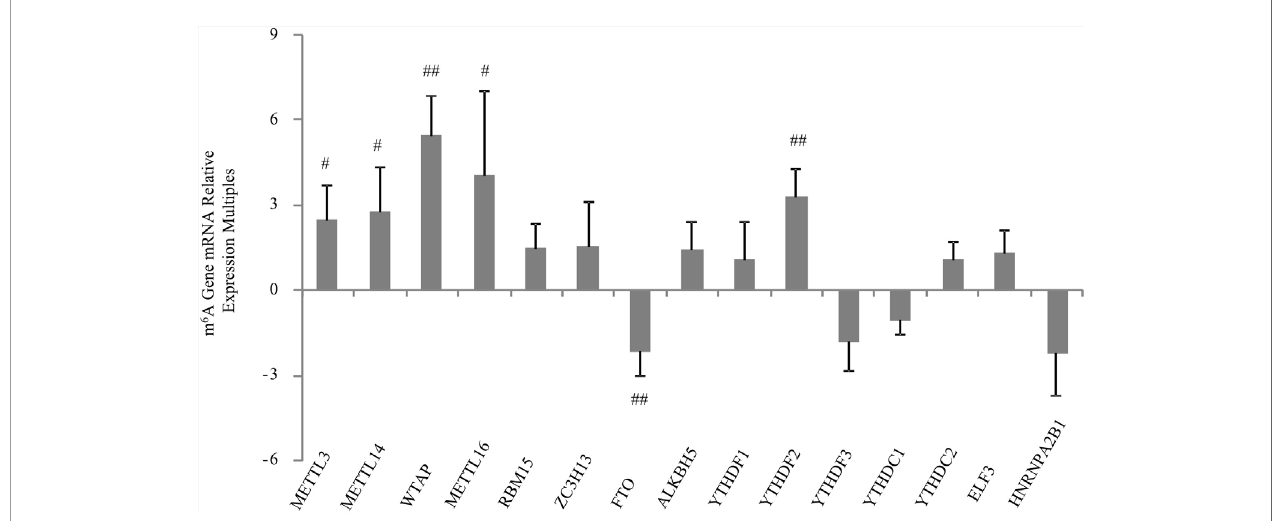
FIGURE 3 | mRNA expression of m 6 A-related enzymes was quanti fi ed using qRT-PCR in the synovial tissues of RA and osteoarthritis patients. The histogram represents multiple expressions of m6A-related enzymes in RA. The expression in osteoarthritis is 1. Values represent means ± standard deviations. ## p < 0.01 vs. OA; # p < 0.05 vs. OA.